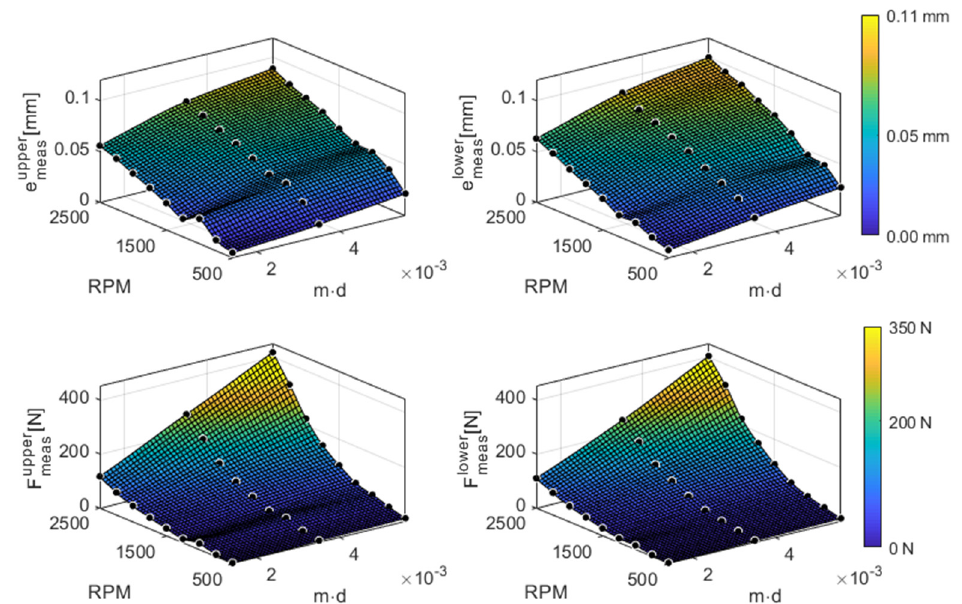
Figure 13. Summary of the measurements showing the mean values of the resultant displacement and reaction forces for the upper and lower bearings. The data points are shown with black circles.